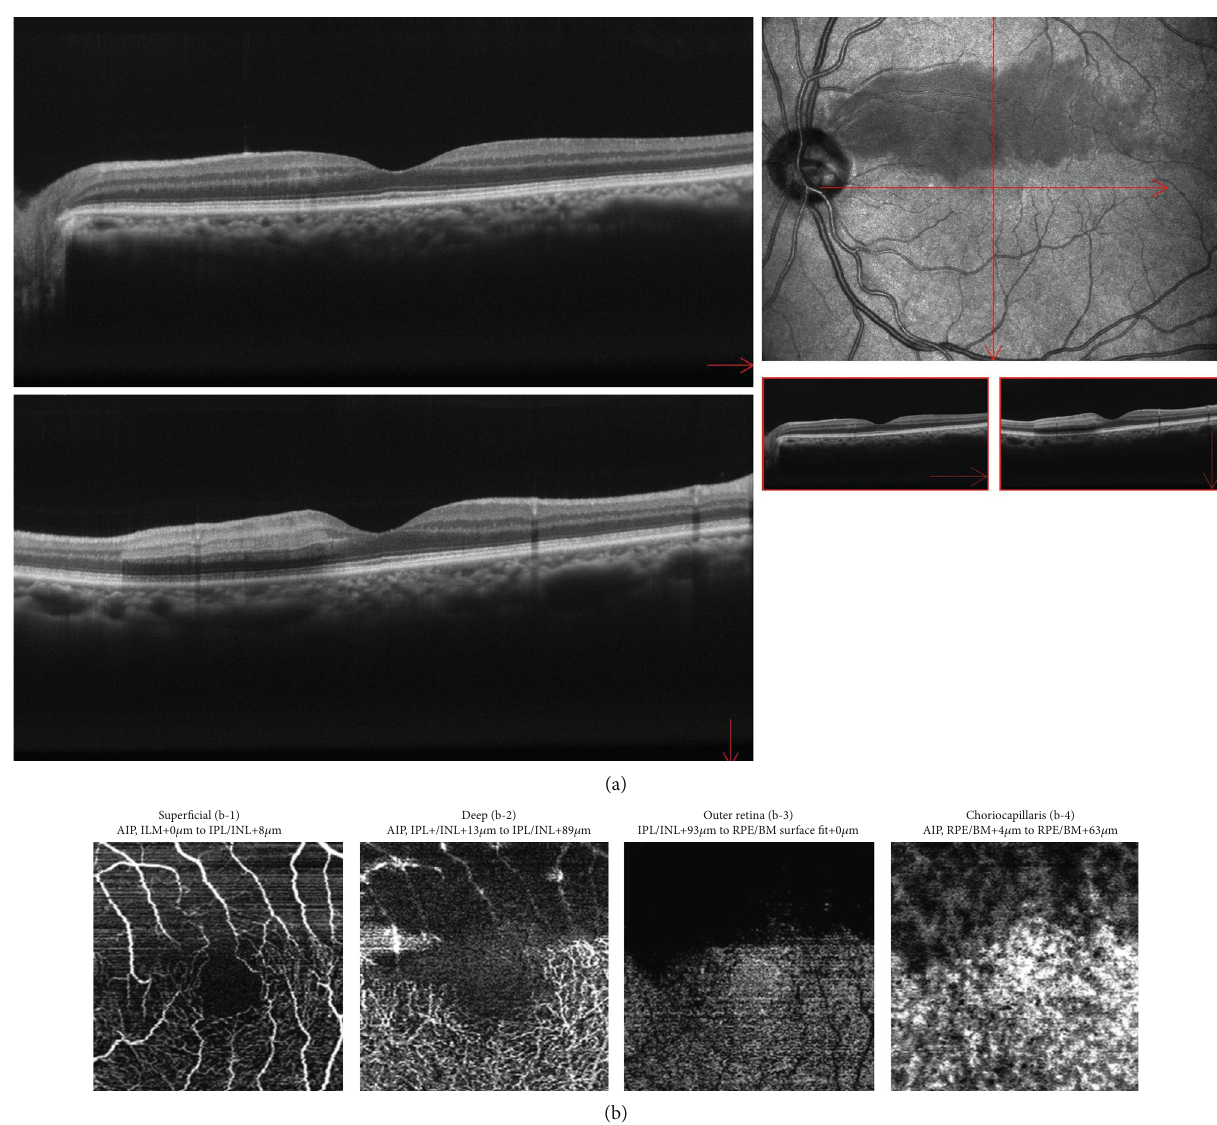
Figure 3: (a) Optical coherence tomography (OCT) and (b) optical coherence tomography angiography (OCTA) (onset): (b-1) super fi cial layer, (b- 2) deep layer, (b-3) outer retina layer, and (b-4) choriocapillaris layer of OCTA. (a) OCT shows a thickening of the inner retinal layer consistent with the white change on the fundus photograph. On infrared re fl ectance images, the area of white change in the fundus photograph is depicted with low luminance, and the area of ischemia can be seen more clearly. (b) In OCTA, the fl ow sign is decreased in all